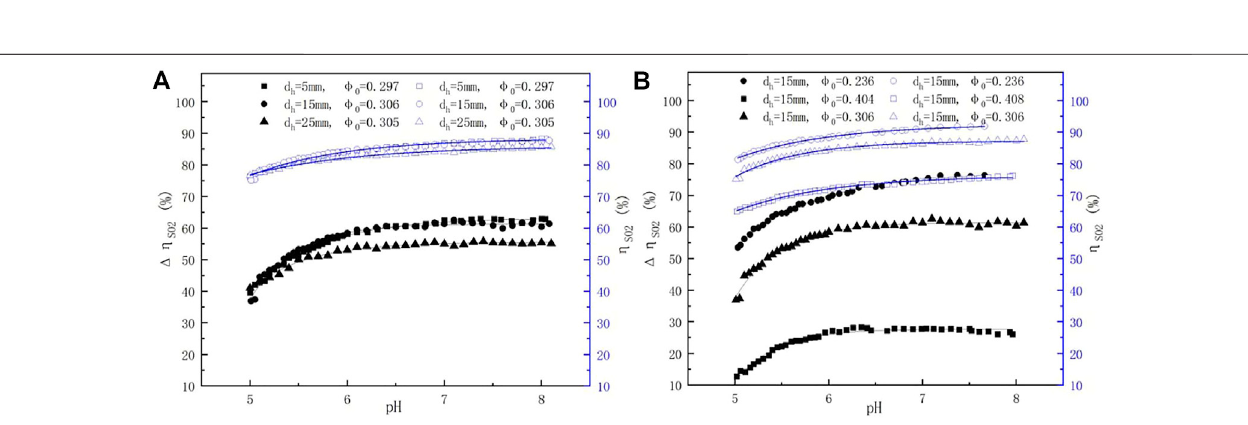
Frontiers in Energy Research |